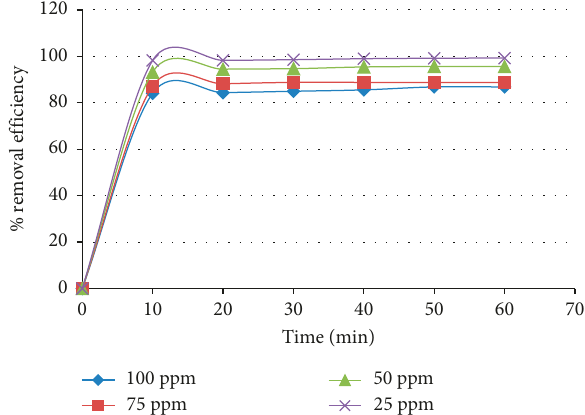
Figure 9: Removal efficiency versus contact time. Solution pH